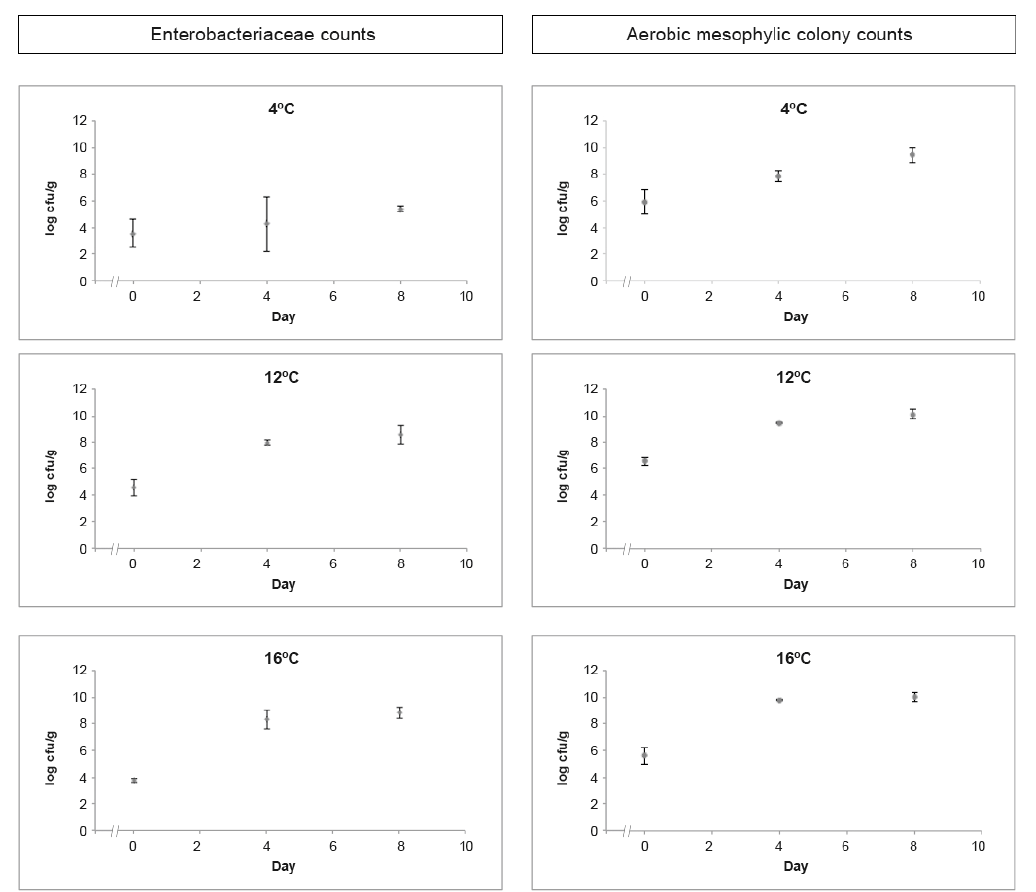
Figure 1. Average and standard deviation of the assessed hygiene indicators (Enterobacteriaceae and aerobic mesophilic colony counts) in log cfu/g obtained from RTE salads at 4 °C, 12 °C, and 16 °C throughout the shelf-life study.